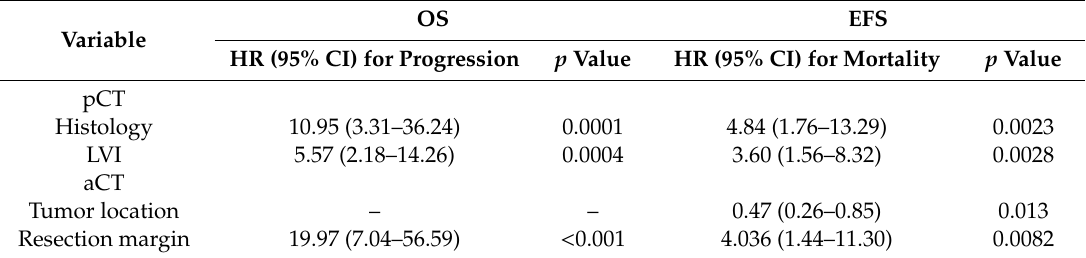
Table 3. Multivariate Cox Regression Analysis of EFS and OS for Clinicopathologic Variables Resulted Significant in Univariate Analysis; pCT and aCT